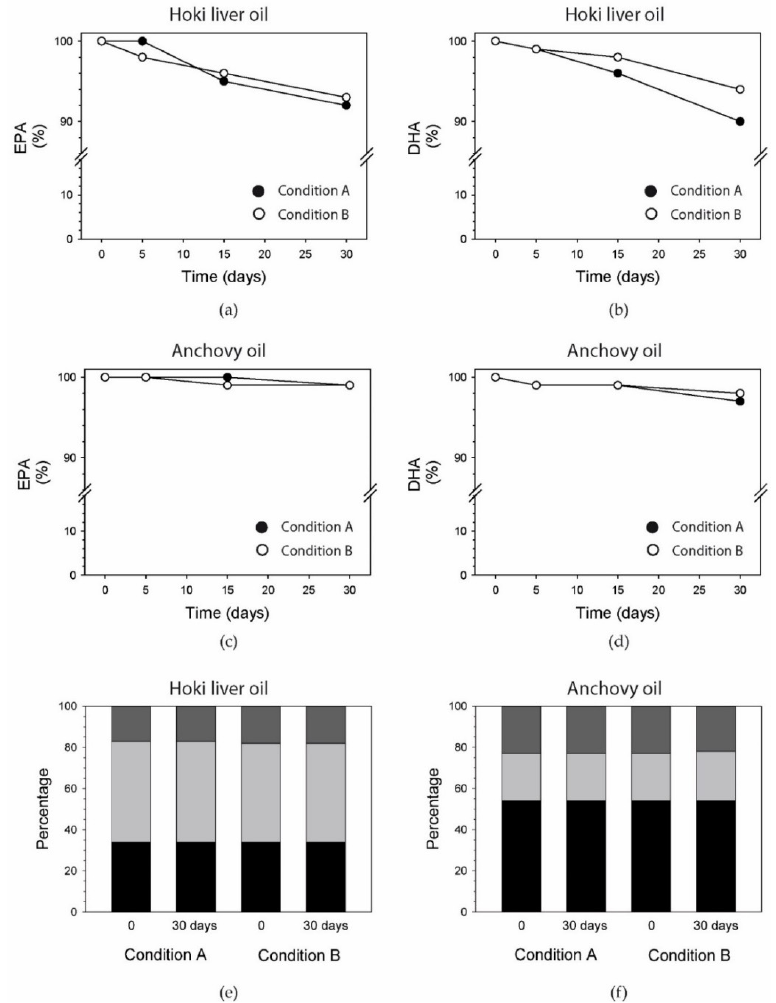
Figure 3. Changes in eicosapentaenoic acid (EPA) and docosahexaenoic acid (DHA) content during the over-oxidation of ( a , b ) hoki liver oil and ( c , d ) anchovy oil. Hoki liver oil started with 66 mg/g EPA and 129 mg/g DHA. Anchovy oil started with 136 mg/g EPA and 122 mg/g DHA. Results are means